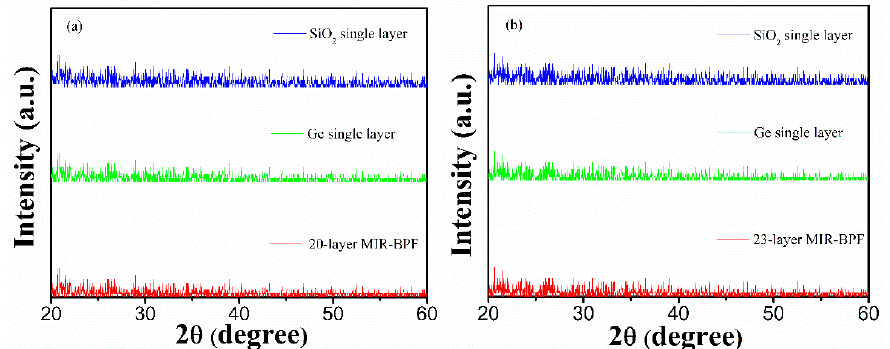
Figure 8. The surface roughness of ( a ) 20-layer; ( b ) 23-layer BPFs.